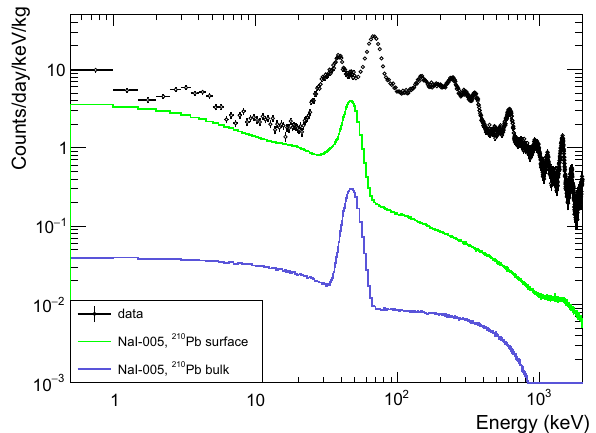
Fig. 6 Simulated background spectra from bulk 210 Pb ( solid blue line ) and a 210 Pb surface ( solid green line )